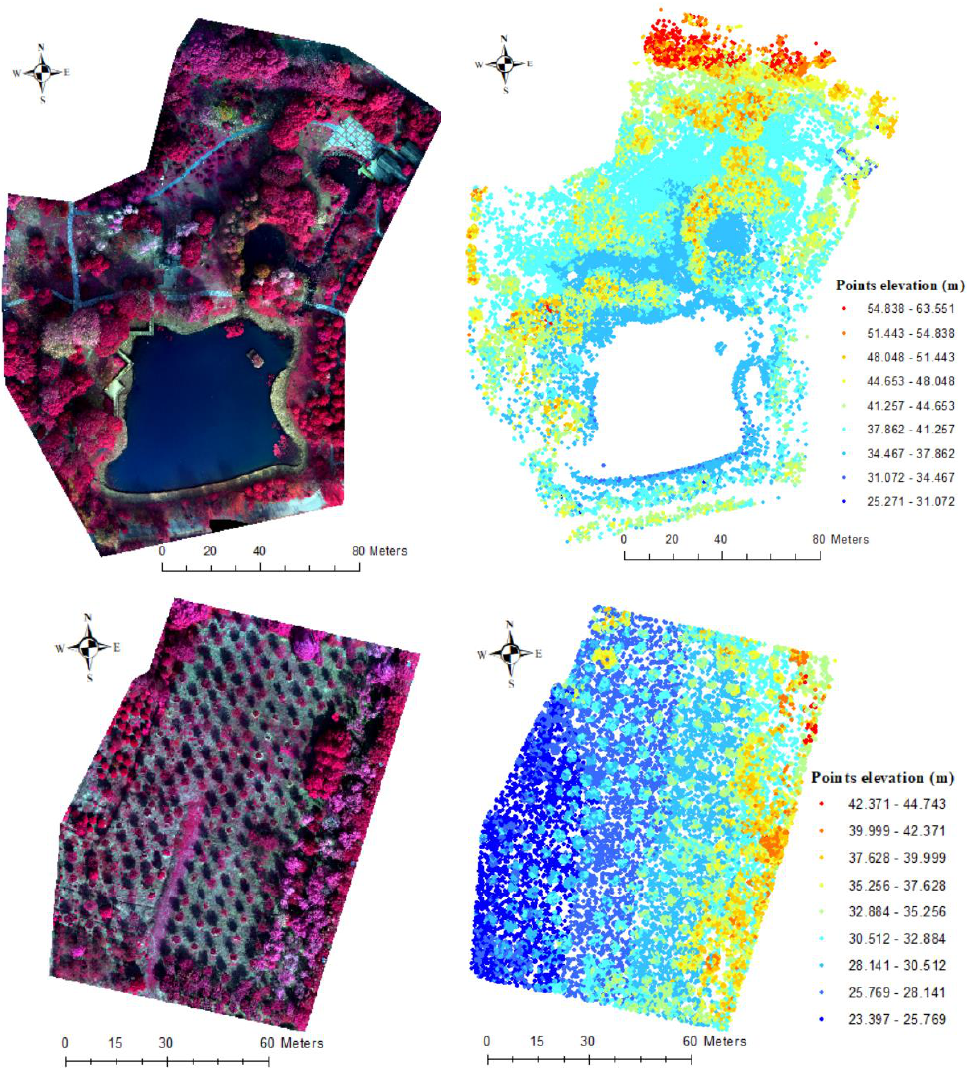
Fig.5 Registration results of the two study